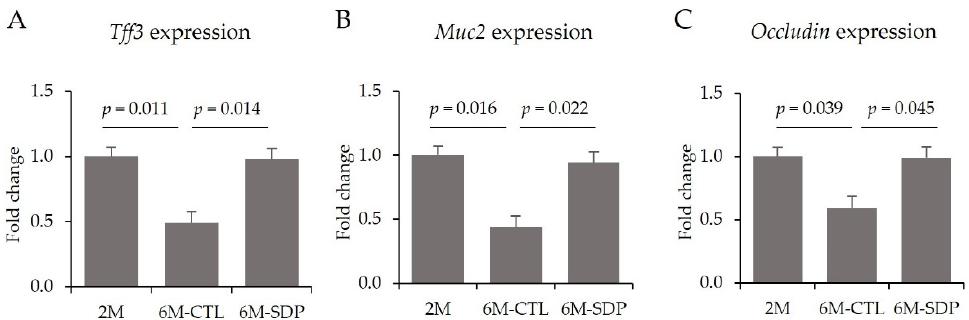
Figure 13. Intestinal barrier. Gene expression of Tff3 ( A ), Muc2 ( B ), and Occludin ( C ). Results are expressed as mean ± SEM ( n = 9 − 11 mice/group). Statistics: ANOVA (Fisher multiple comparison test). Muc2, mucin 2; Tff3, trefoil factor 3.